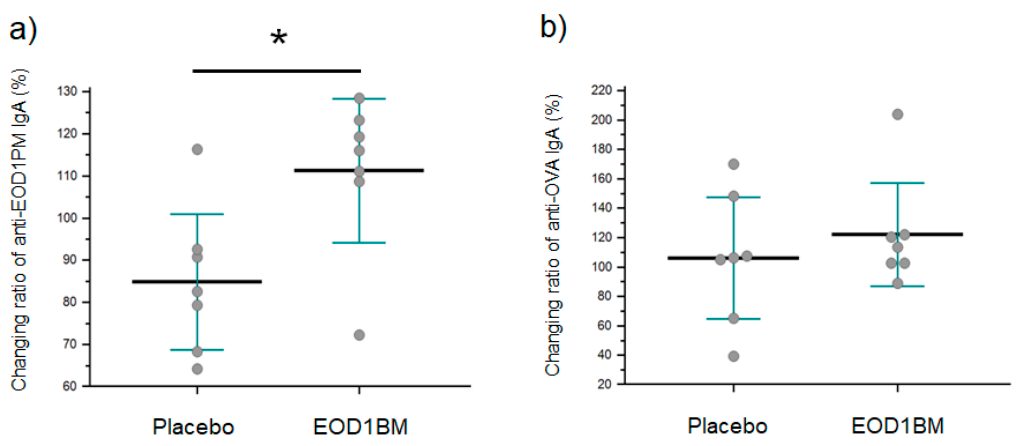
Figure 7. Changes in anti- Euglena gracilis EOD-1 paramylon (EOD1PM) antibody titer after EOD1BM ingestion. The anti-EOD1PM antibody titer was measured by ELISA using sEOD1PM-coated plates ( n = 7). The rate of increase in the titer was calculated using the following formula: Increase in anti-EOD1PM antibody titer (%) = ((anti-EOD1PM antibody titer after ingestion—anti-EOD1PM antibody titer before ingestion) / anti-EOD1PM antibody titer before ingestion) × 100. *: p < 0.05 (Mann–Whitney U test, n = 7). ( a ) Changes in anti-EOD1PM antibody titer after EOD1BM ingestion. ( b ) Changes in anti-OVA antibody titer after EOD1BM ingestion.